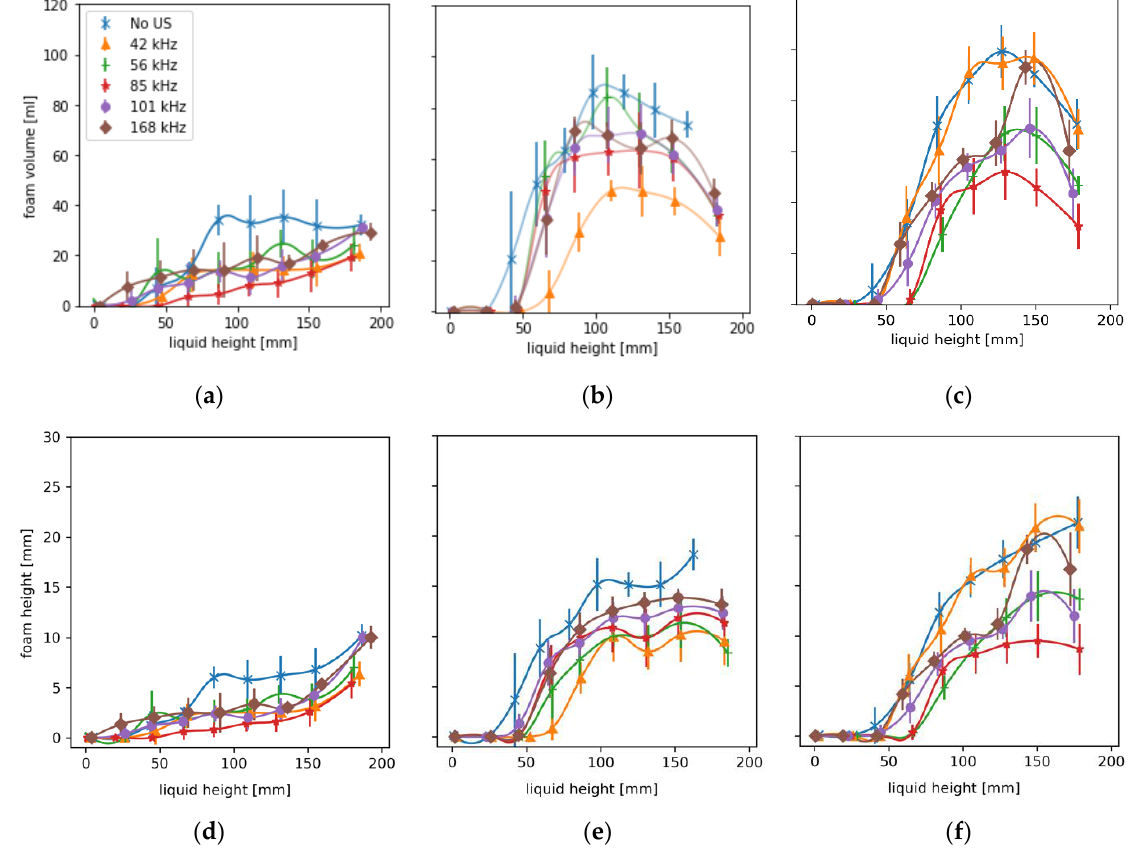
Figure 3. Effect of frequency dependent, permanent ultrasound insonication on the evolution of foam volume ( a – c ) and foam height ( d – f ) for orange juice ( a , d ), apple juice ( b , e ), and currant nectar ( c , f ), each at 70 °C, n = 6.